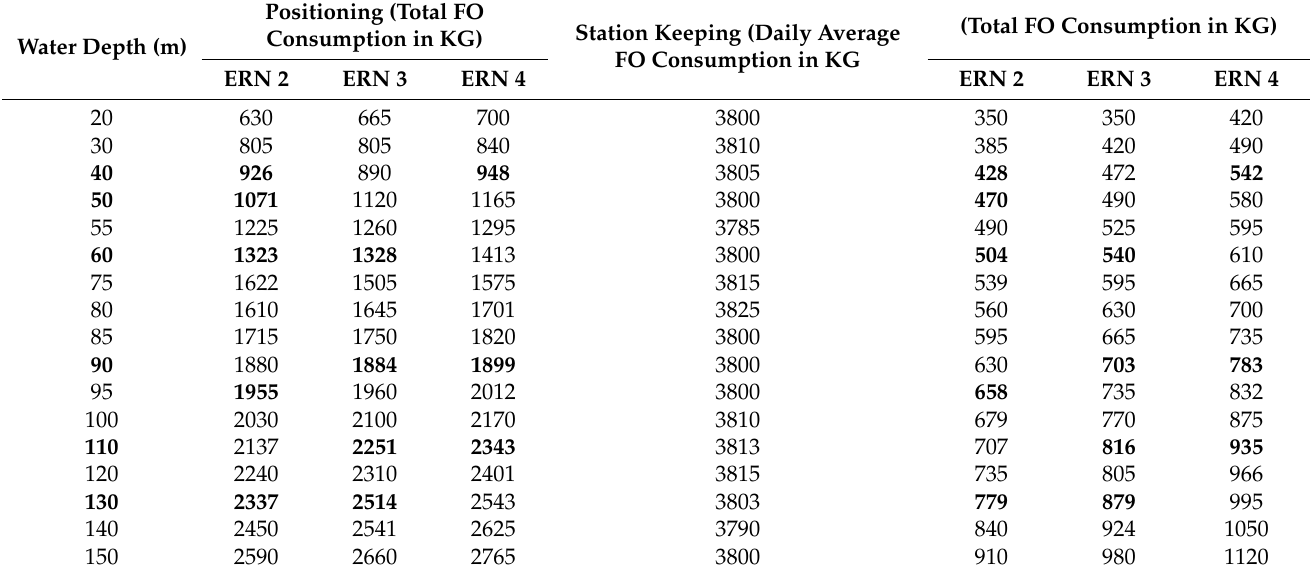
Table 7. FO consumption in SM for various ERN and water